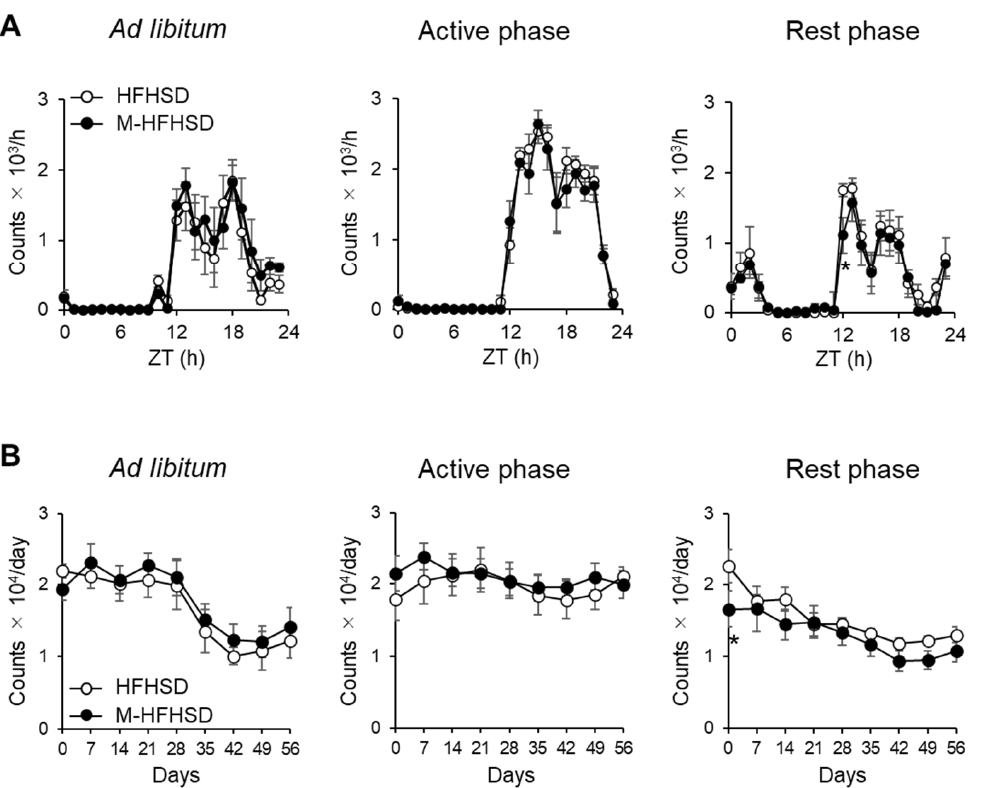
Figure 1. Effect of MCT intake on voluntary wheel-running activity in mice. ( A ) Hourly count/24 h of mouse wheel-running activity after 8 weeks of consuming HFHSD or M-HFSHD) ( B ) Daily wheel-running activity by mice fed with HFHSD or M-HFHSD. Data are shown as means ± SEM ( n = 6). * p < 0.05 vs. M-HFHSD at the same time. HFHSD, high-fat high-sucrose diet; MCT, medium- chain triglyceride; M-HFHSD, high-fat high-sucrose diet containing medium-chain triglyceride; ZT, zeitgeber time.